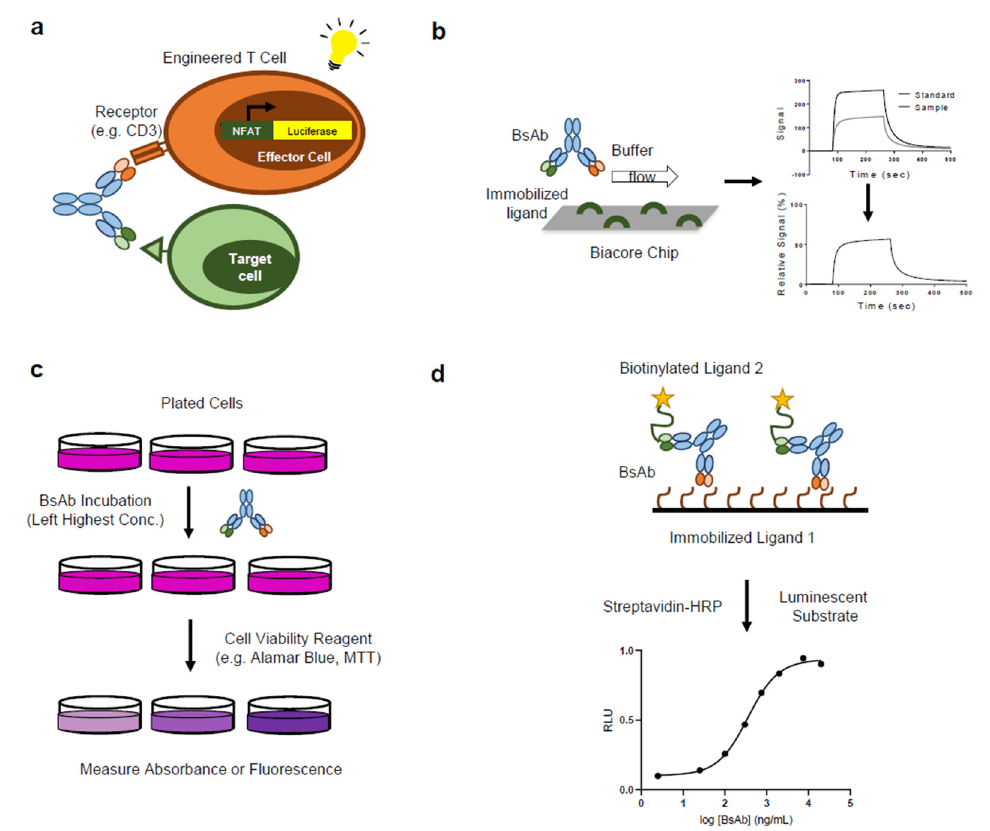
Figure 3. Representative bioassays for BsAb: ( a ) Reporter gene T-cell activation assay; ( b ) Single-arm binding SPR assay; ( c ) Cell proliferation assay; ( d ) Bridging ELISA. MTT:3-(4,5-dimethylthiazol-2-yl)-2,5-diphenyl-2H-tetrazolium Table 2. BsAb categories and potential bioassays applicable: Summary of case studies.